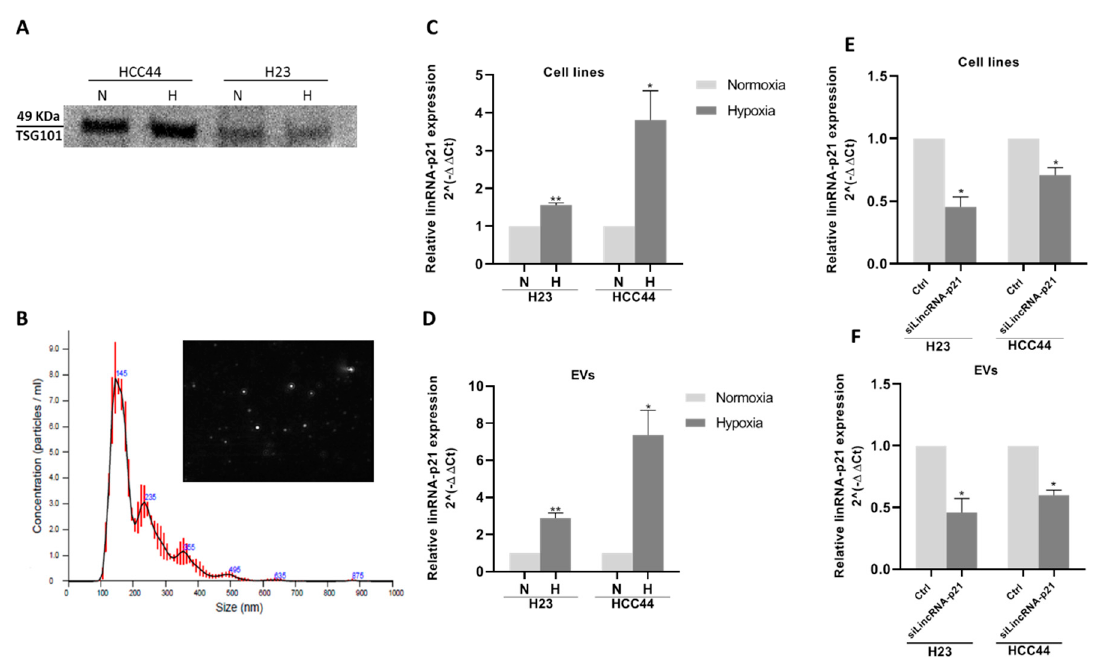
Figure 2. ( A ) Western blot against exosomal marker TSG101 from HCC44 and H23 cell lines under normoxic or hypoxic conditions. ( B ) Nanoparticle tracking analysis (NTA) report of the average distribution of particle size in a representative exosomal sample derived from HCC44 cells; lincRNA-p21 is overexpressed under hypoxic conditions in both ( C ) cell lines and ( D ) EVs. siRNA transfection against lincRNA ‐ p21 under hypoxic conditions reduced its expression in both ( E ) cell lines and ( F ) EVs.